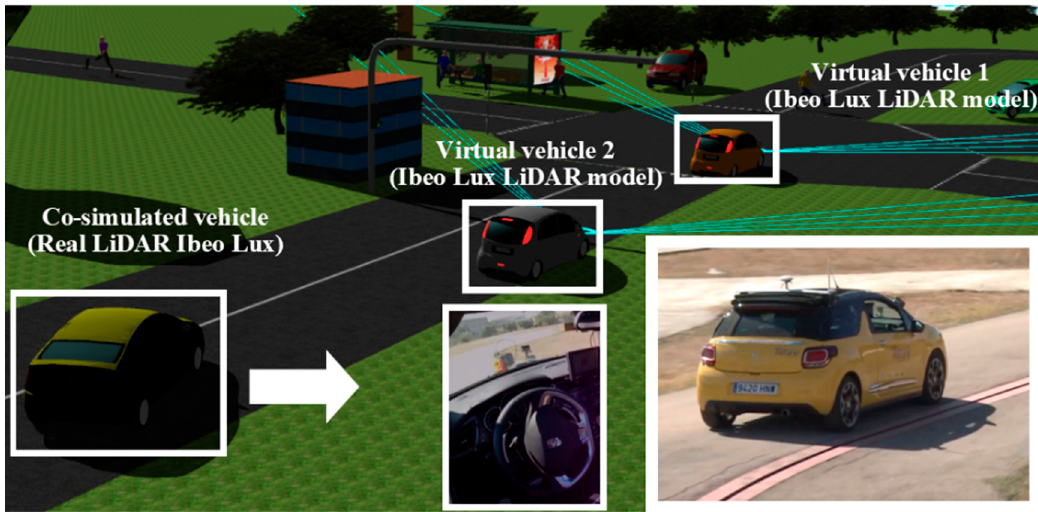
Figure 5. Data interchange between LiDAR sensors in (virtual and real) driving assistance scenarios in Webots for automobiles.